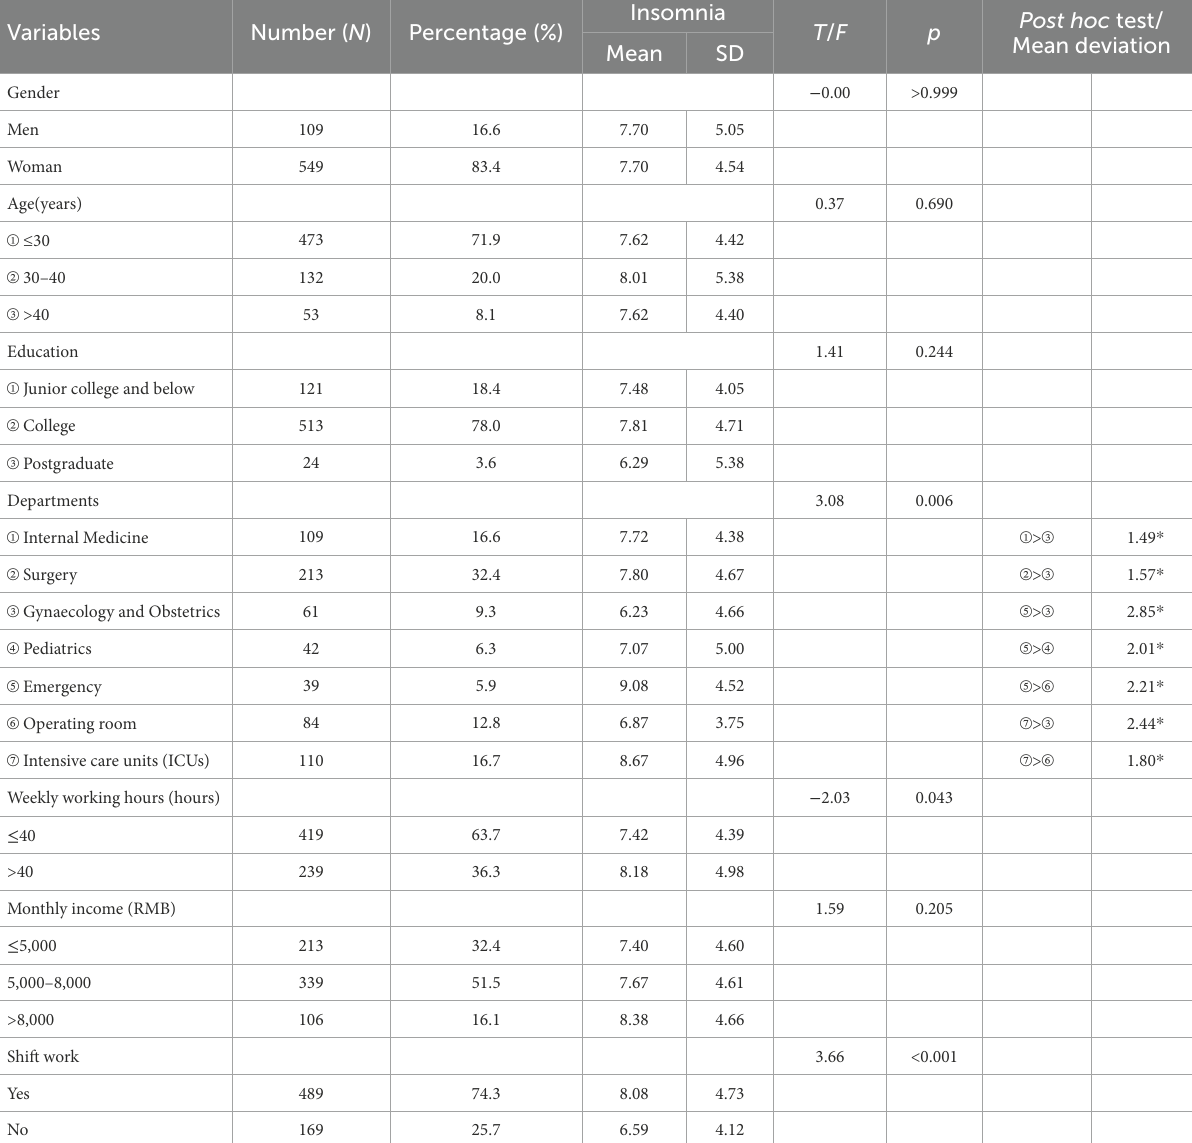
TABLE 1 Demographic statistics and the influence of demographic information and life behavior factors on